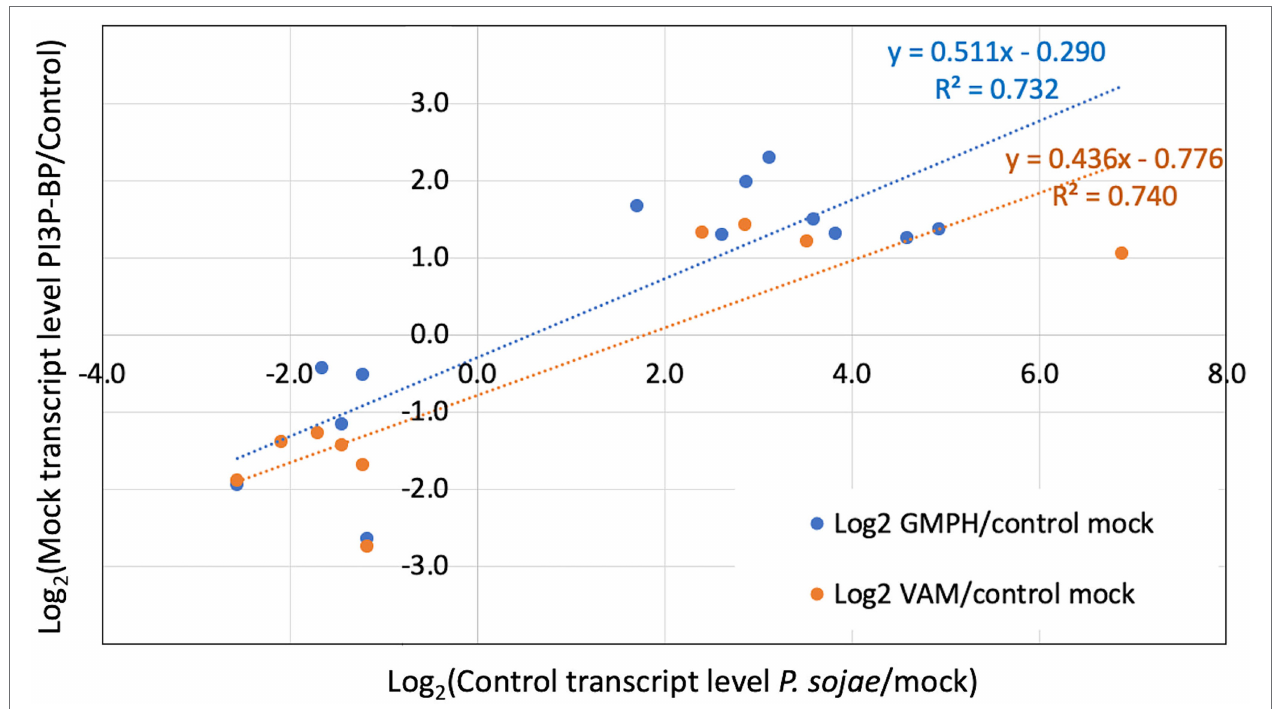
FIGURE 6 | Correlation of relative transcript levels in mock inoculated GmPH and VAM lines with relative transcript levels in P. sojae -inoculated control lines. Only genes exhibiting significant changes in both Mock GmPH/Control and P. sojae /Mock Control or both Mock VAM/Control and P. sojae /Mock Control are included.